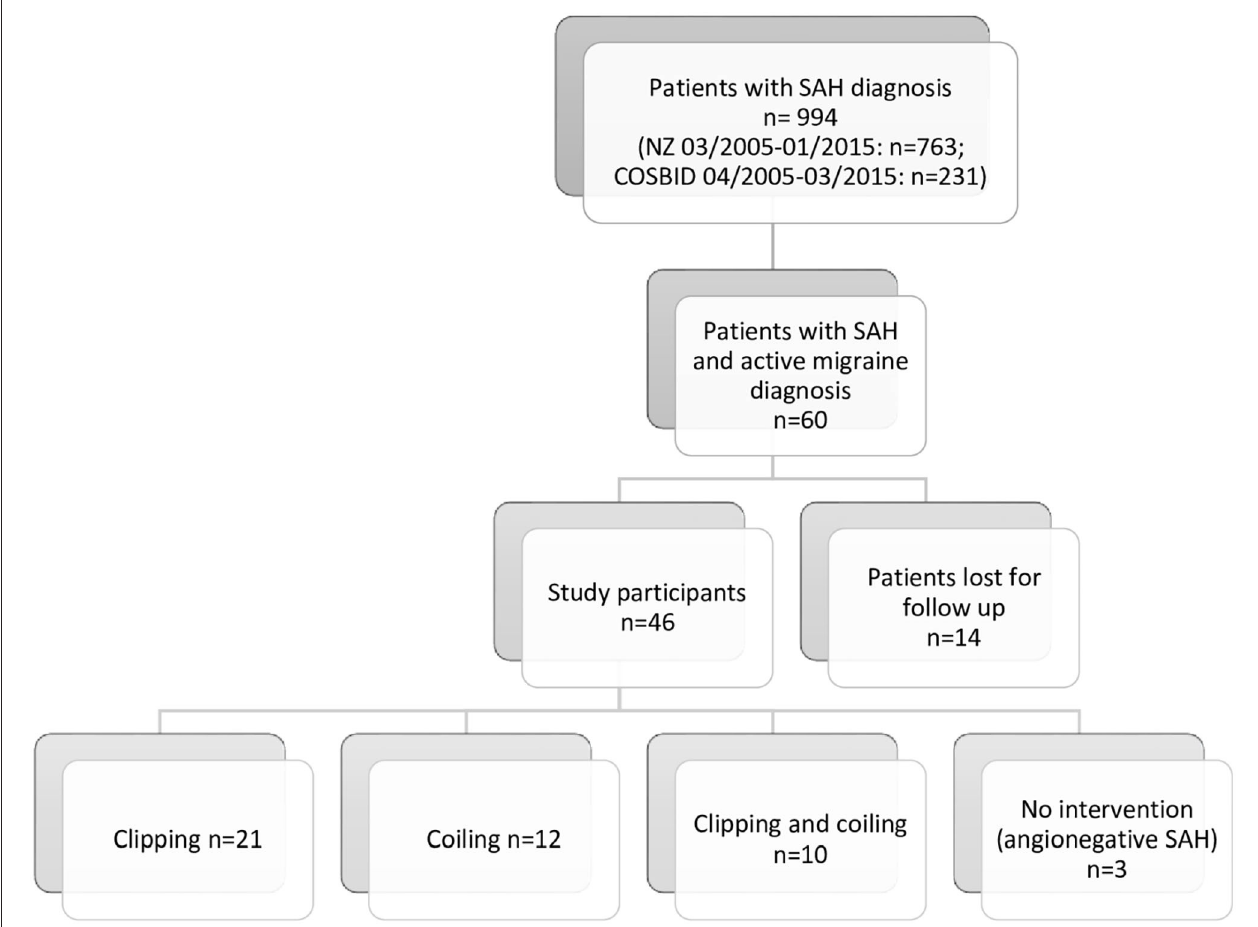
FIGURE 1 | Overview of patient flow (NZ, center for neurological rehabilitation; COSBID, Co-Operative Studies on Brain Injury Depolarizations).